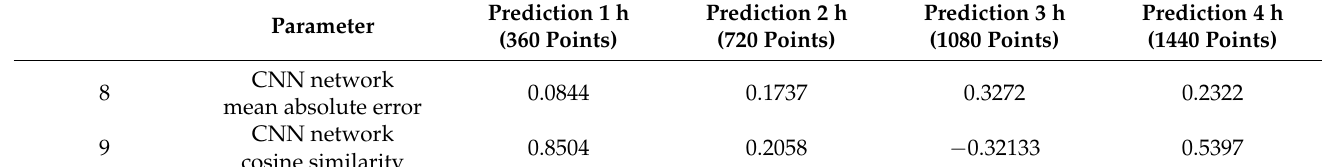
10 of 17 Table 4. Comparison of prediction evaluation metrics for performed forecasts. Parameter